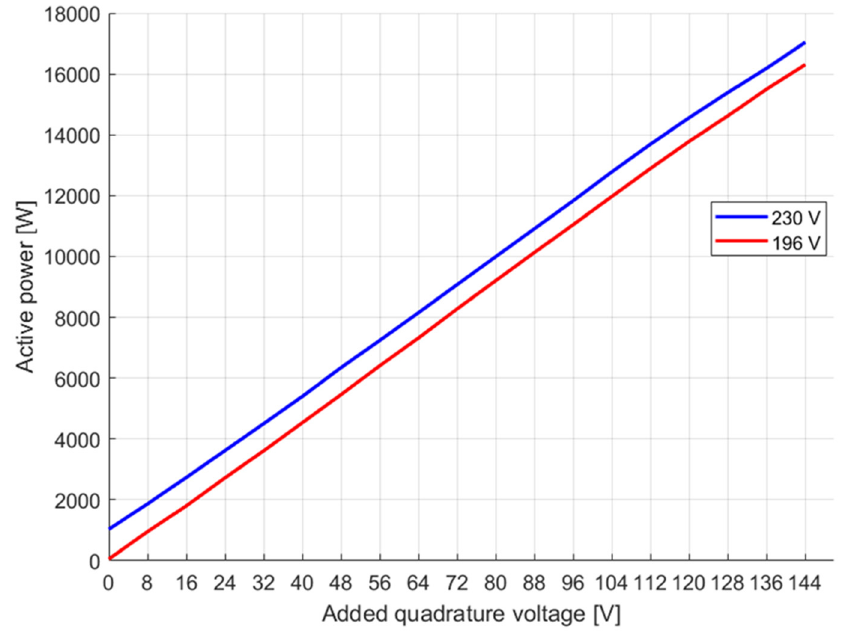
Figure 12. Active power transfer for two longitudinal voltage cases: 230 V (blue) and 196 V (red). Table 3. The ACPST output voltages for 230 V and 196 V longitudinal